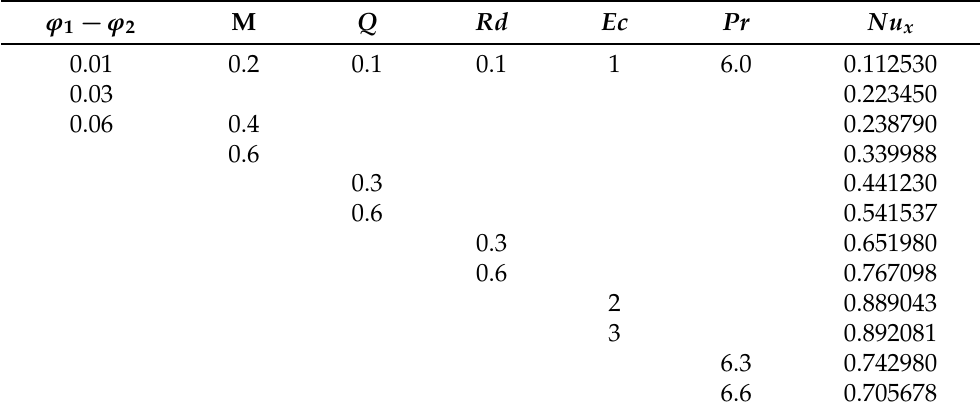
Table 3. Variations in the Nu x Re − 0.5 x values under the impact of different